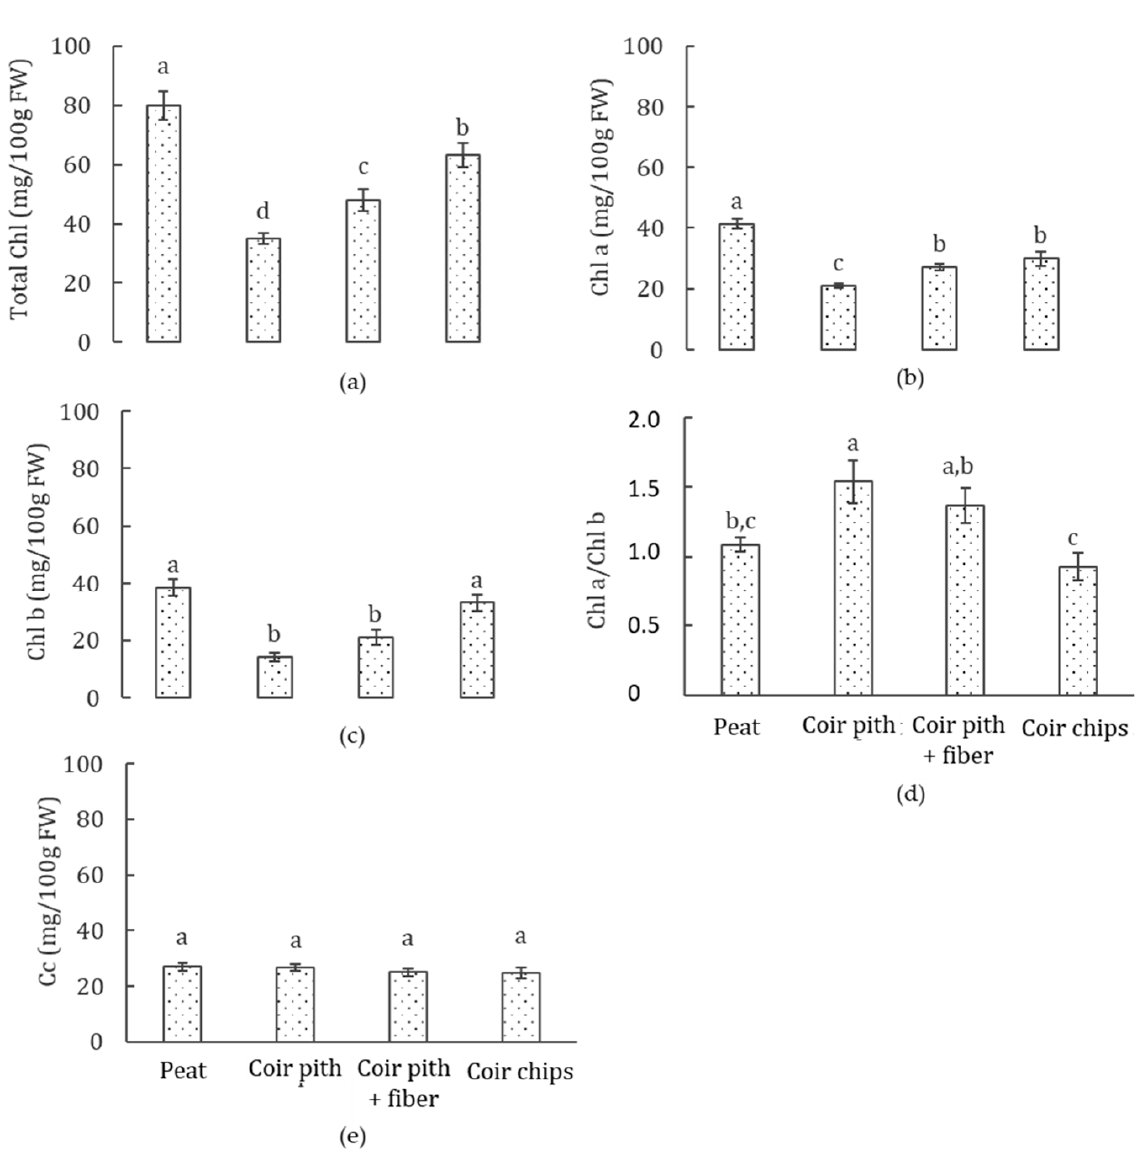
Figure 3. Accumulation of photosynthetic pigments (total chlorophyll ( a ), Chl a ( b ), Chl b ( c ), and carotenoids (Cc) ( e )) and Chl a/Chl b ratio ( d ). Means with different letters are significantly different at p < 0.05; FW—fresh weight. Each bar represents the mean of five replicates, and the error bars represent ± 1SE. Abiotic stresses have negative influences on chlorophyll biosynthesis [48]. Salinity reduces the contents of photosynthetic pigments [49,50]. Average levels of chlorophyll were lower in plants with average values of Zn > 200 µ g g − 1 , that is, in plants grown in coir pith and coir pith + fiber. As previously mentioned, high levels of Zn in spinach can decrease the chlorophyll